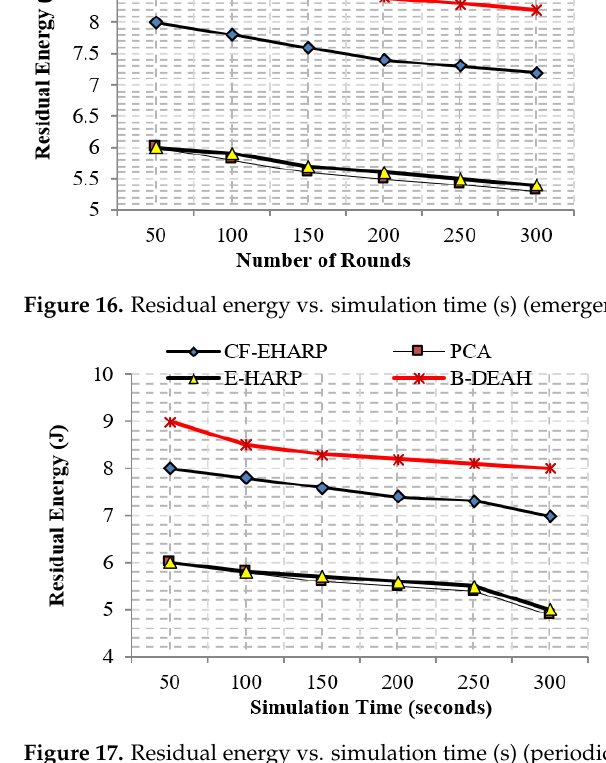
Figure 17. Residual energy vs. simulation time (s) (periodic